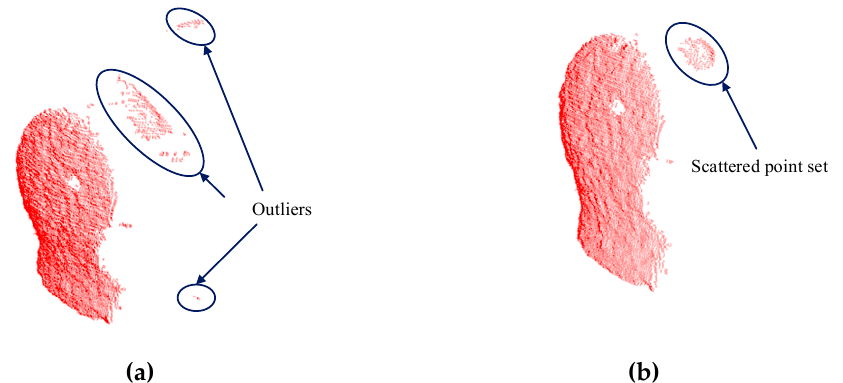
Figure 9. Comparison of outliers removal results. ( a ) There are a lot of obvious outliers in the original point cloud before using outliers removal. ( b ) A majority of the outliers are removed after using outliers removal, but there are some very dense point sets that cannot be removed totally.